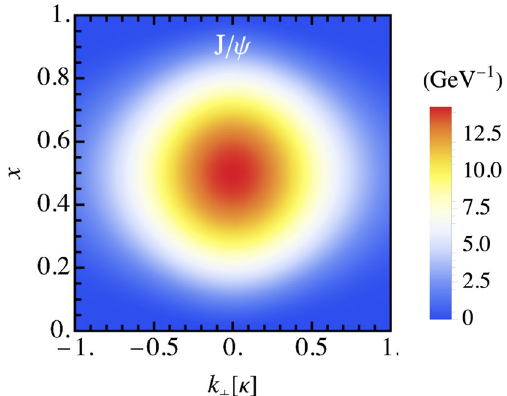
Fig. 5 Plot of the J /ψ wavefunction according to Eq. (49) as a func- tion of x and (cid:3) k ⊥ at θ k = 0 ,π , with the basis parameter κ = 1 . 34 GeV. All three polarized states of J /ψ have the same spatial dependence, ( (cid:3) k ⊥ , x ) = ψ m j = 1 ( (cid:3) k ⊥ , x ) = ψ m j =− 1 ( (cid:3) k ⊥ , x ) . The mag- ψ m j = 0 ↑↓+↓↑ / J /ψ ↑↑ / J /ψ ↓↓ / J /ψ nitude of the wavefunction is in GeV −